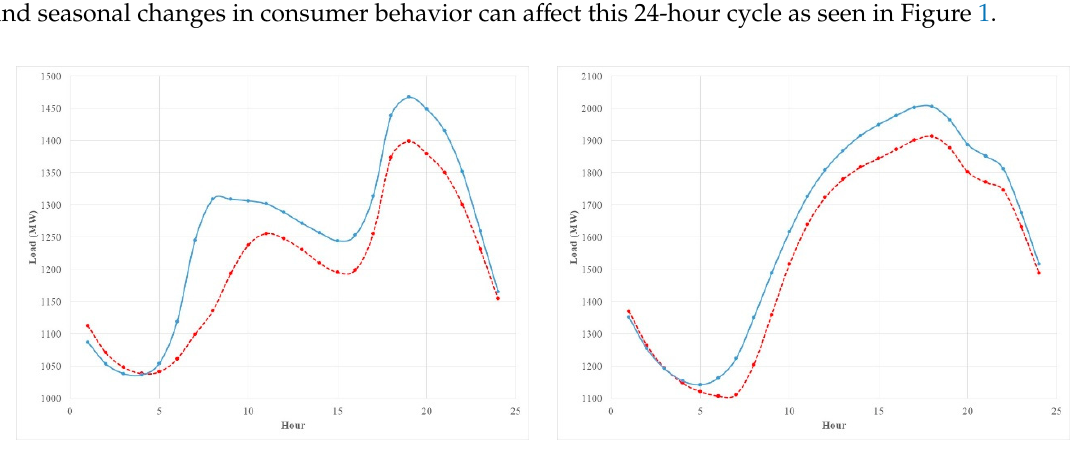
Figure 1. The average of a 24-hour of load curve of weekdays (blue solid) and weekends (red dashed) 1993–2012 ( left : January; right : July).